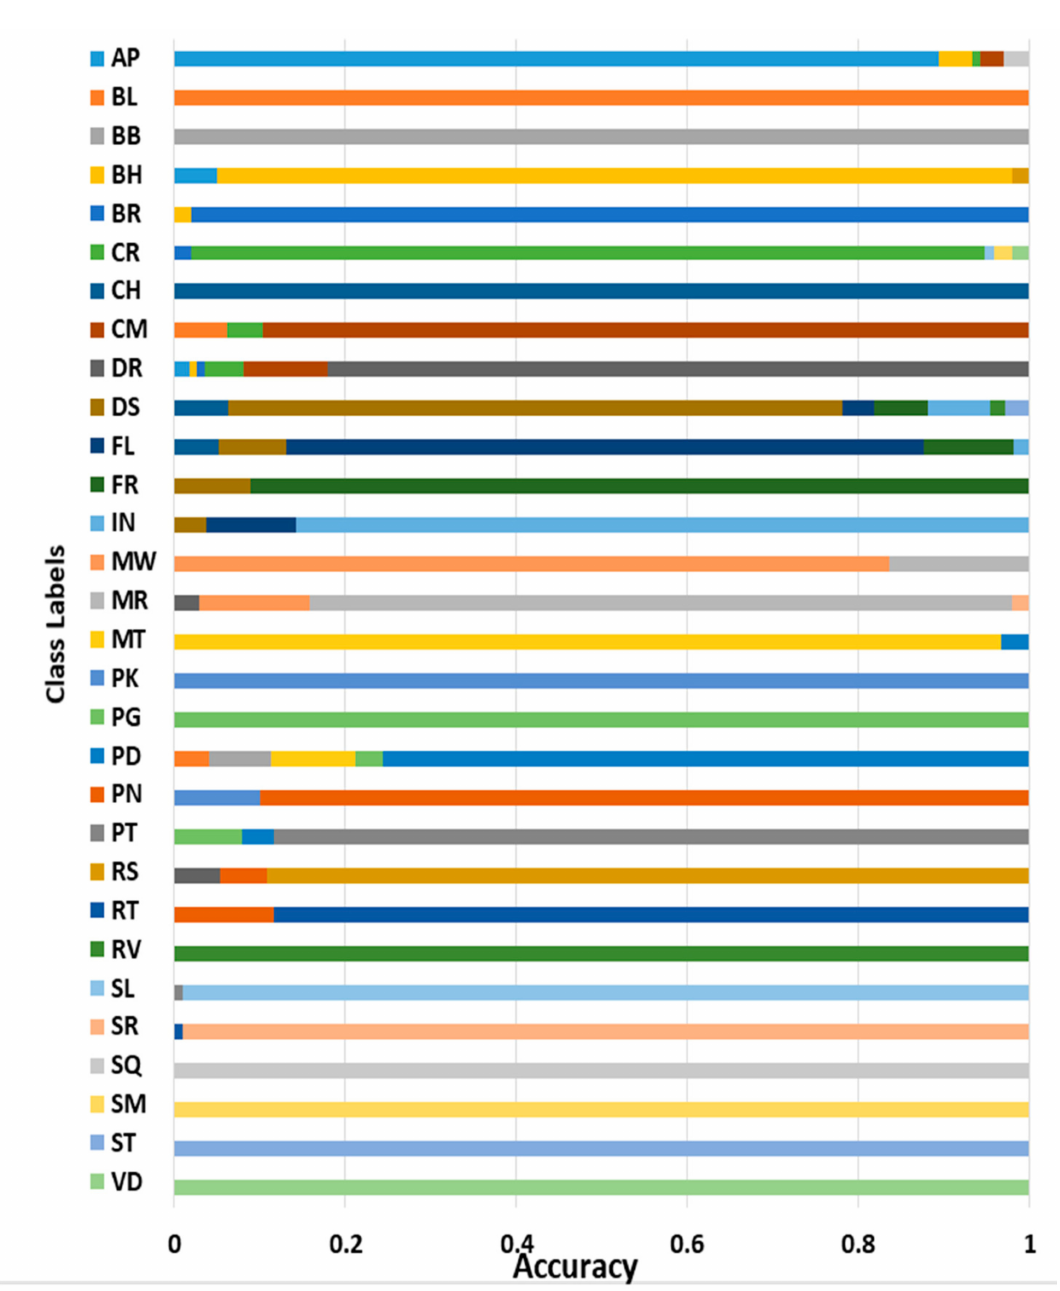
Figure 14. The recognition accuracy of OCSC model over AID. AP = airplane; BL = bare land; BB = baseball field; BH = beach; BR = bridge; CR = center; CH = church; CM = commercial; DR = dense residential; DS = desert; FL = farmland; FR = forest; IN = industrial; MW = meadow; MR = medium residential; MT = mountain; PK = park; PG = parking; PD = playground; PN = pond; PT = port; RS = railway station; RT = resort; RV = river; SL = school; SR = sparse residential; SQ = square; SM = stadium; ST = storage tank; VD =